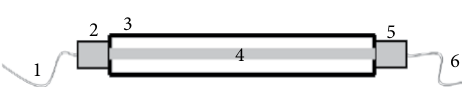
Fig. 14. The scheme of the smoke density sensor: 1 – a cable